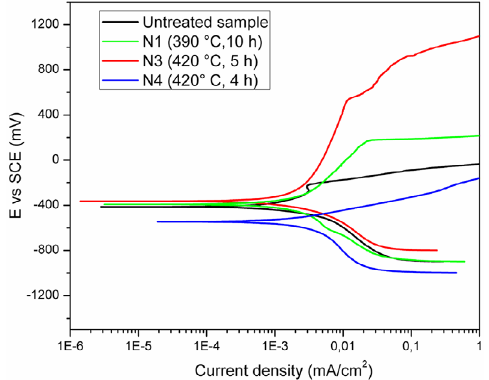
Figure 6. Potentiodynamic curves for nitrided samples.